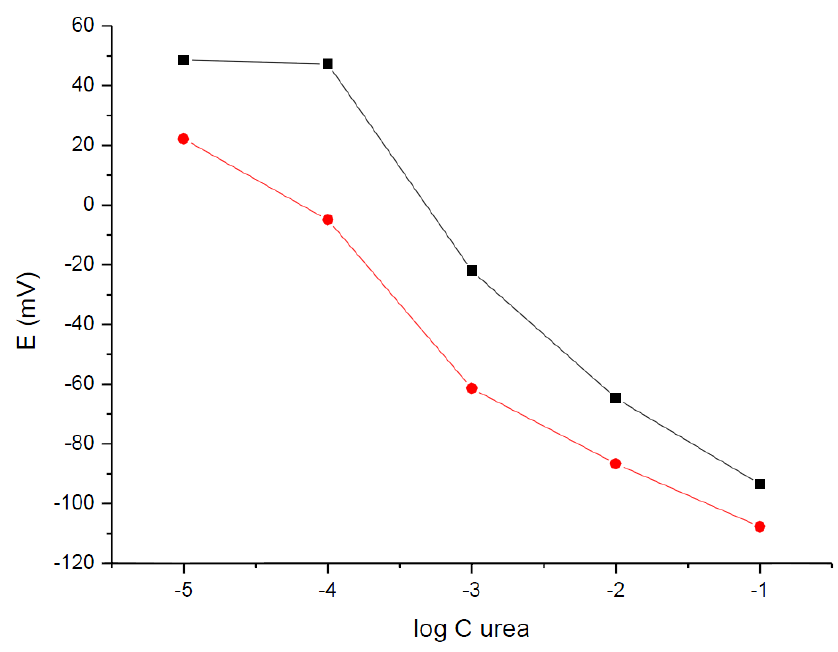
Figure 4. Potentiometric response of urea biosensors using H + -ISE carbon-plastic electrodes recorded in (■) 10 −4 M Tris, pH = 7.19 and (●) H 2